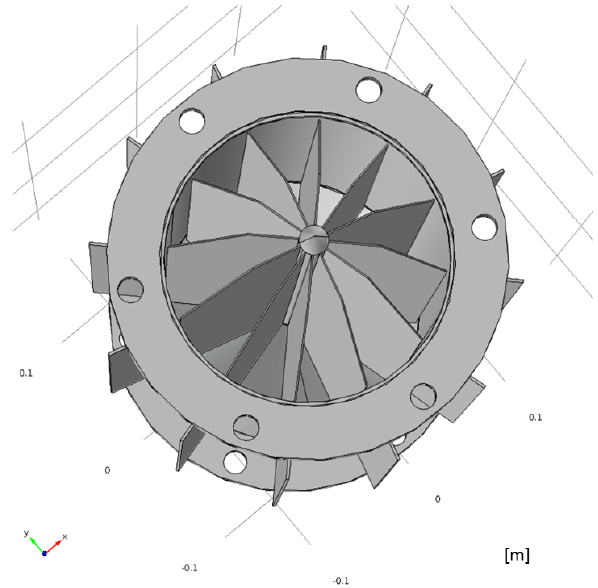
Figure 5. The internal structure of the CLACE 2013 droplet evapo- ration unit as seen from